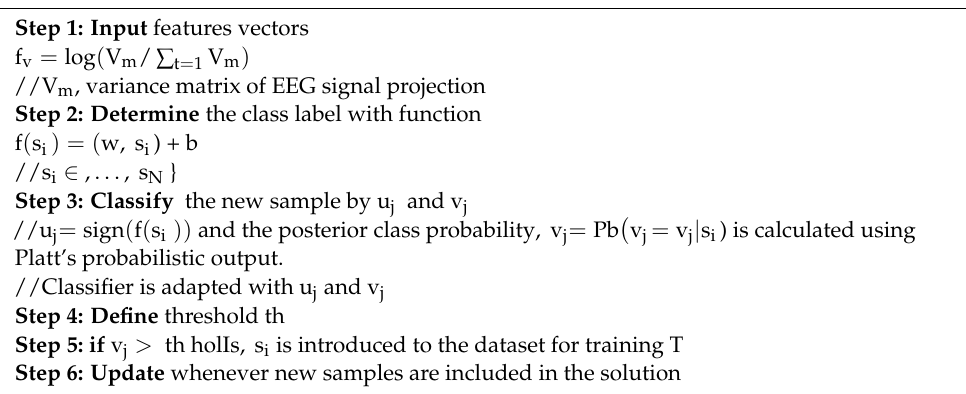
Algorithm 2: A-SVM with